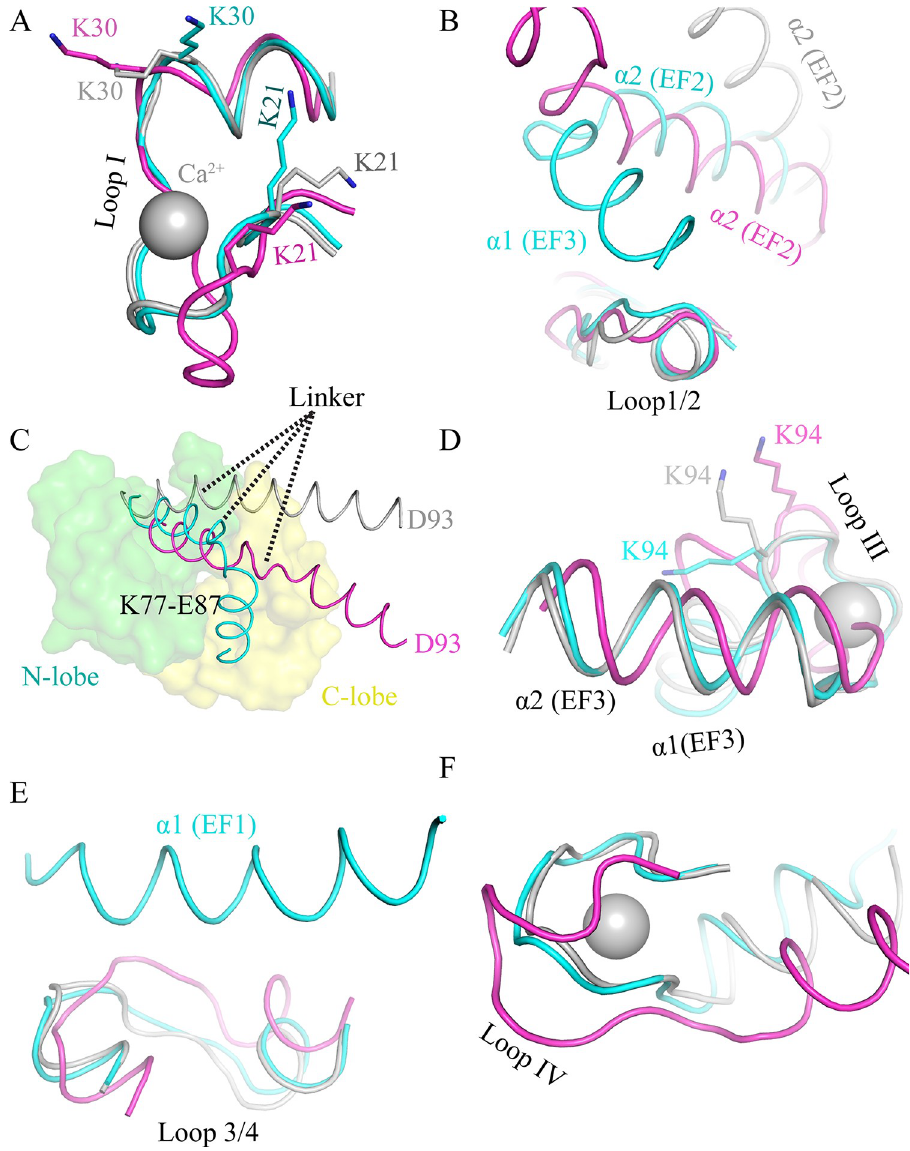
Fig 4. Structural basis of root mean-square fluctuations in various CaM loops regions. (A) Loop I (EF1) hand motif is stabilized by the K21 residue in the compact CaM structure. (B) Loop 1/2 is stabilized in both the apo CaM and the compact CaM structures by the close proximity of the helices α 1 (EF3) and α 2 (EF2). (C) The central helix is entrapped between the two lobes in the compact CaM structure (D) Loop III (EF3) is stabilized by K94 in the compact CaM structure. (E) Loop 3/4 exhibits limited movement in compact CaM due to being in close proximity to helix α 1 (EF1). (F) Loop IV (EF4) is highly flexible in apo CaM due to its unusual conformation. The extended Ca 2+ /CaM, apo CaM, and the compact Ca 2+ /CaM are shown in grey, magenta, and cyan, respectively. remains free in all CaM structures (Fig 3A and 3B). Loop1/2 (L39-E47) that connects EF1 and EF2 is on the surface in the extended Ca 2+ /CaM and is highly flexible (RMSF ~ 0.50 nm). However, in compact Ca 2+ /CaM structure, α 2 (EF2) and α 1 (EF3) position close to this loop restricting its flexibility (RMSF ~0.26 nm) (Figs 3A and 4B). In apo CaM, only α 2 (EF2) limits the movement of loop 1/2 (Fig 4B). The EF2 loop II (D56-P66) is less flexible (RMSD 0.2–0.3 nm) compared to EF1 loop in extended conformation. It exhibits even lower RMSD (0.15–